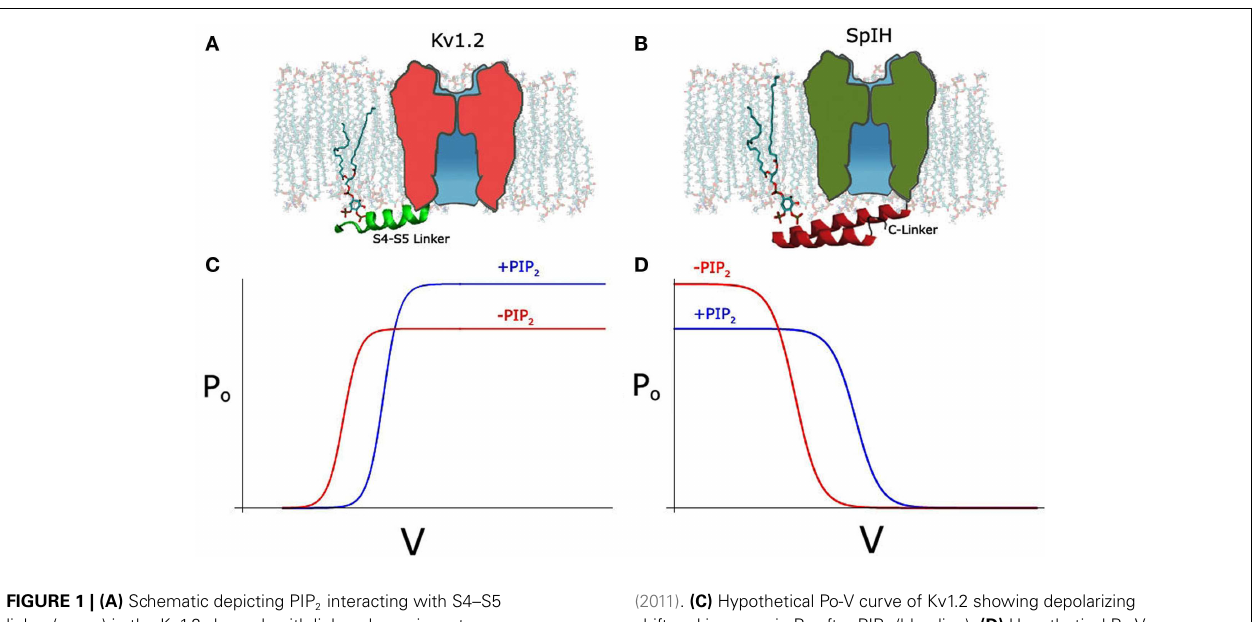
FIGURE 1 | (A) Schematic depicting PIP 2 interacting with S4–S5 linker (green) in the Kv1.2 channel, with linker shown in cartoon representation. (B) Schematic depicting PIP 2 interacting with A (cid:48) helix of C-linker (red) in the SpIH channel, adapted from Flynn and Zagotta